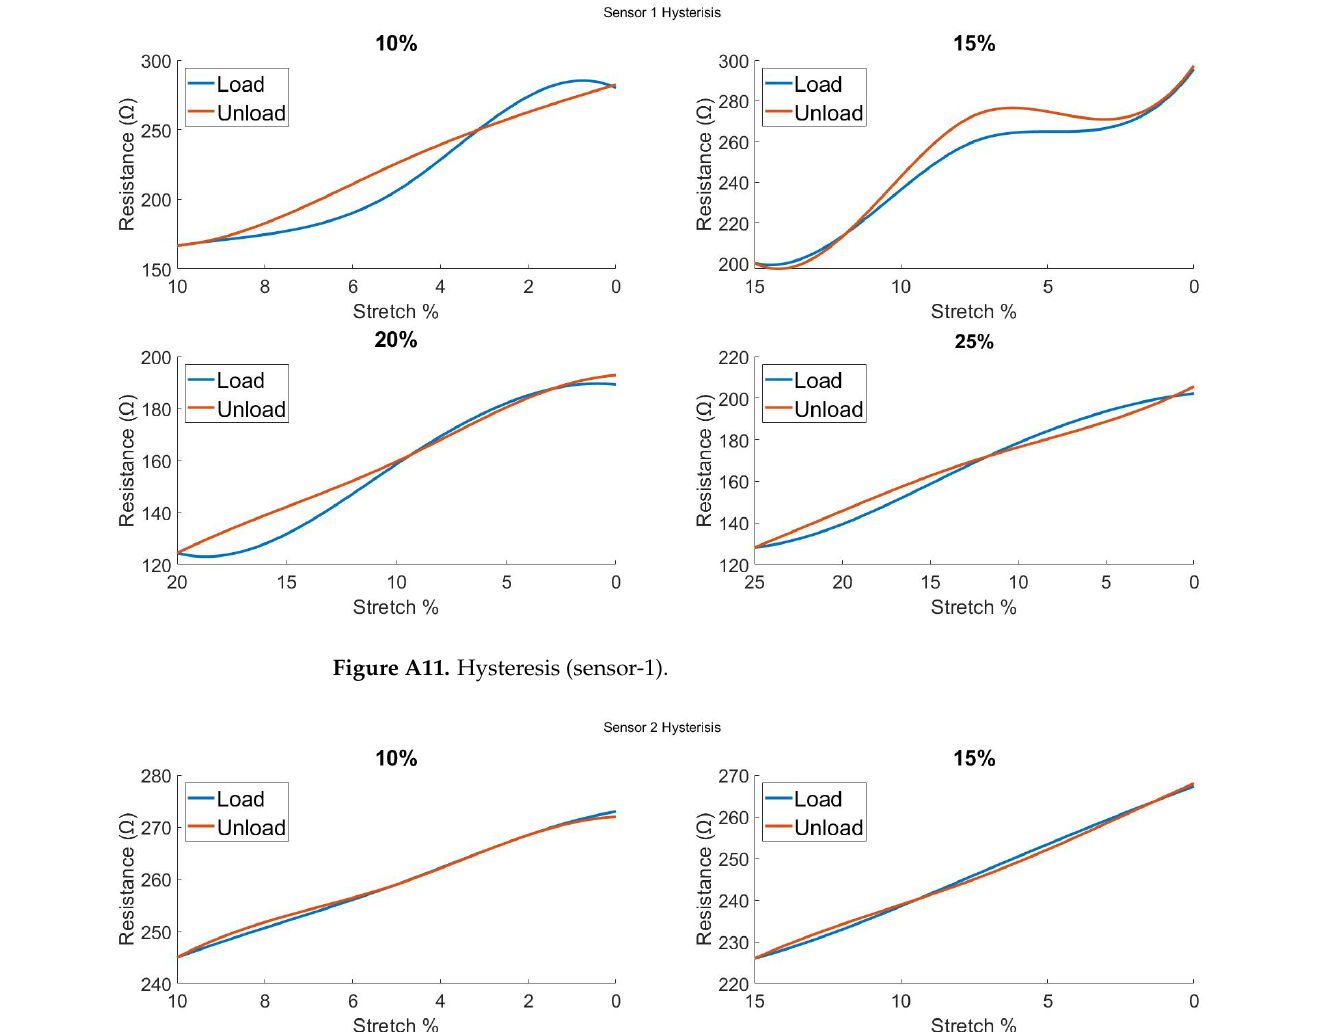
Figure A11. Hysteresis (sensor-1).